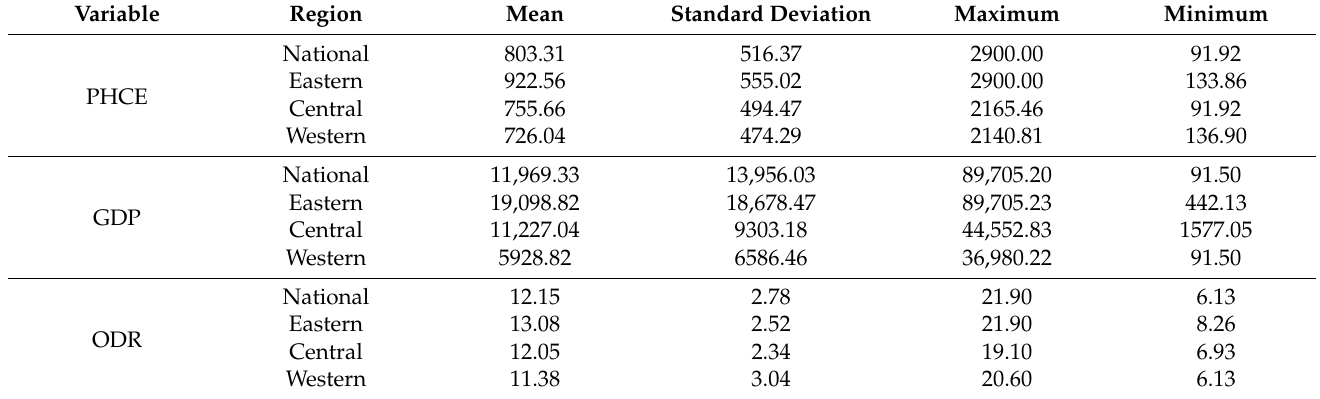
Table 3. Descriptive